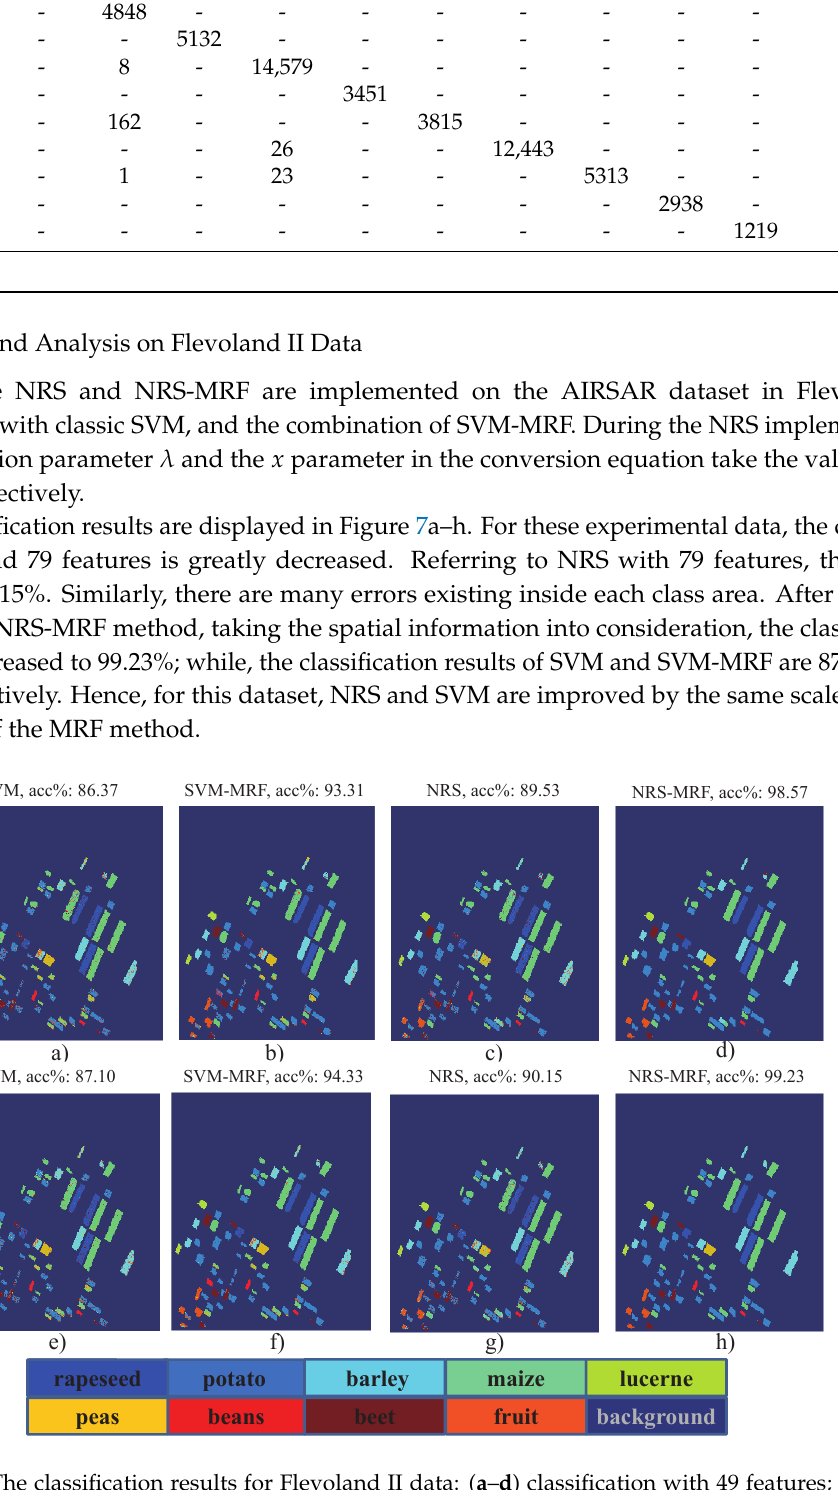
Figure 7. The classification results for Flevoland II data: ( a – d ) classification with 49 features; ( e – h ) classification with 79